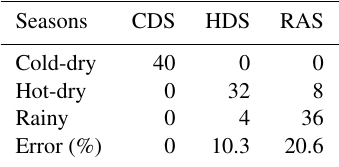
Table 7. Structural matrix with discriminant function for the three seasons.